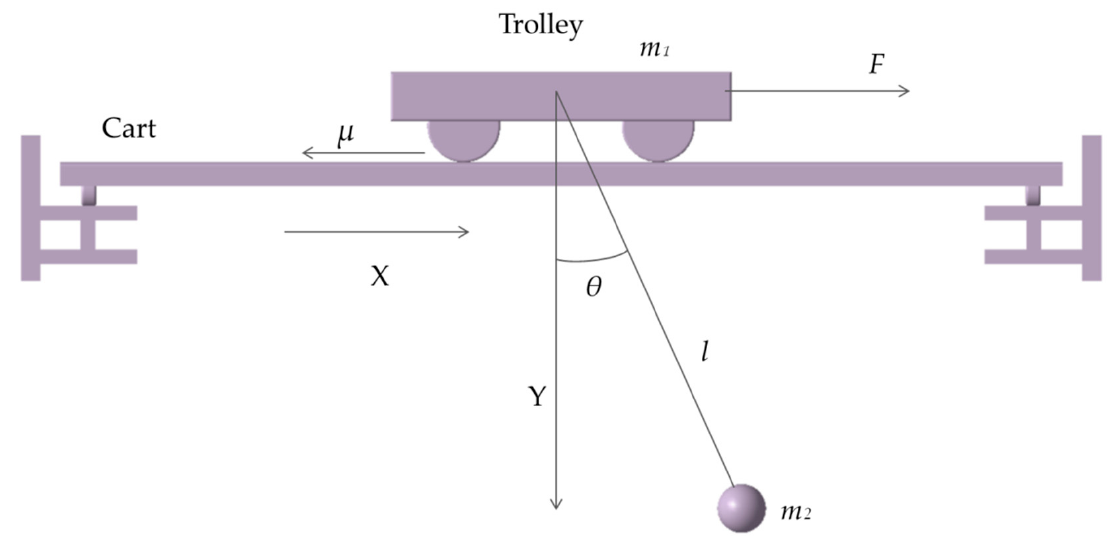
Figure 1. Motion diagram of bridge crane.